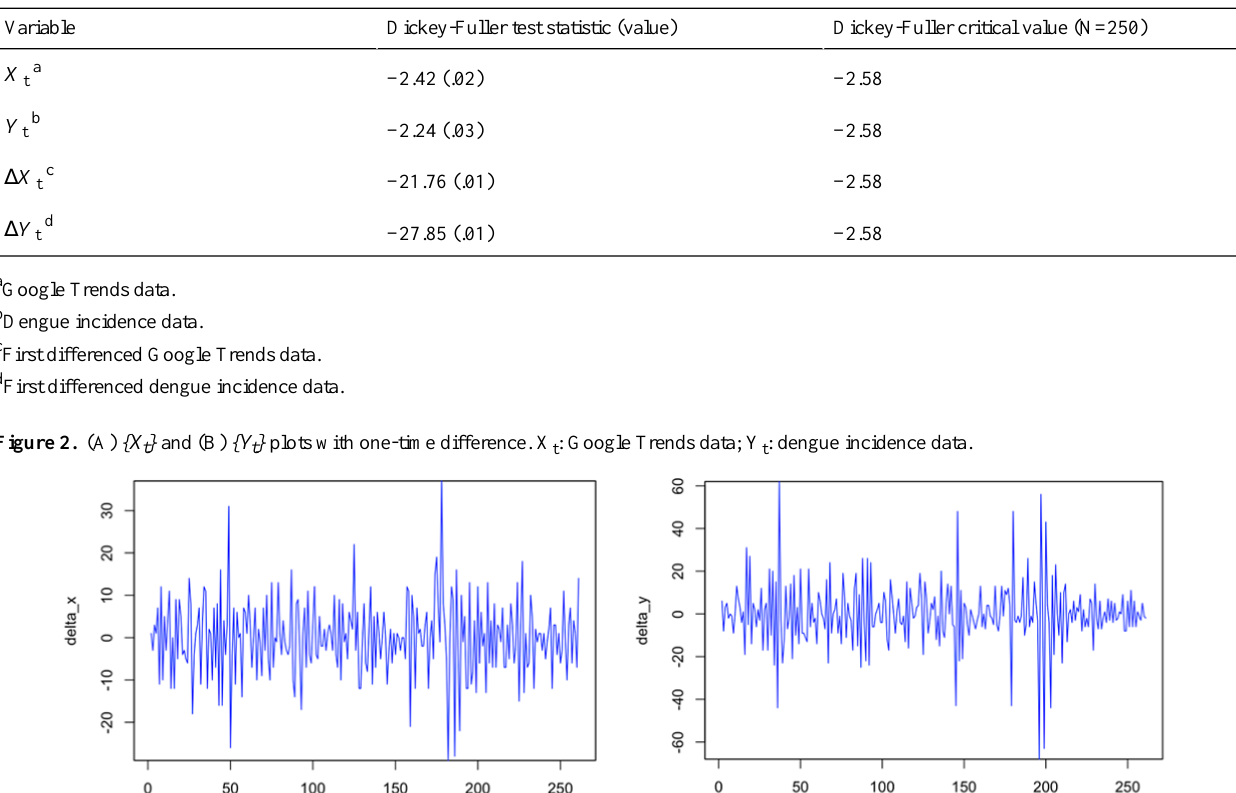
Table 1. Dickey-Fuller test for Google Trends data, dengue incidence data, first differenced Google Trends data, and first differenced dengue incidence data.